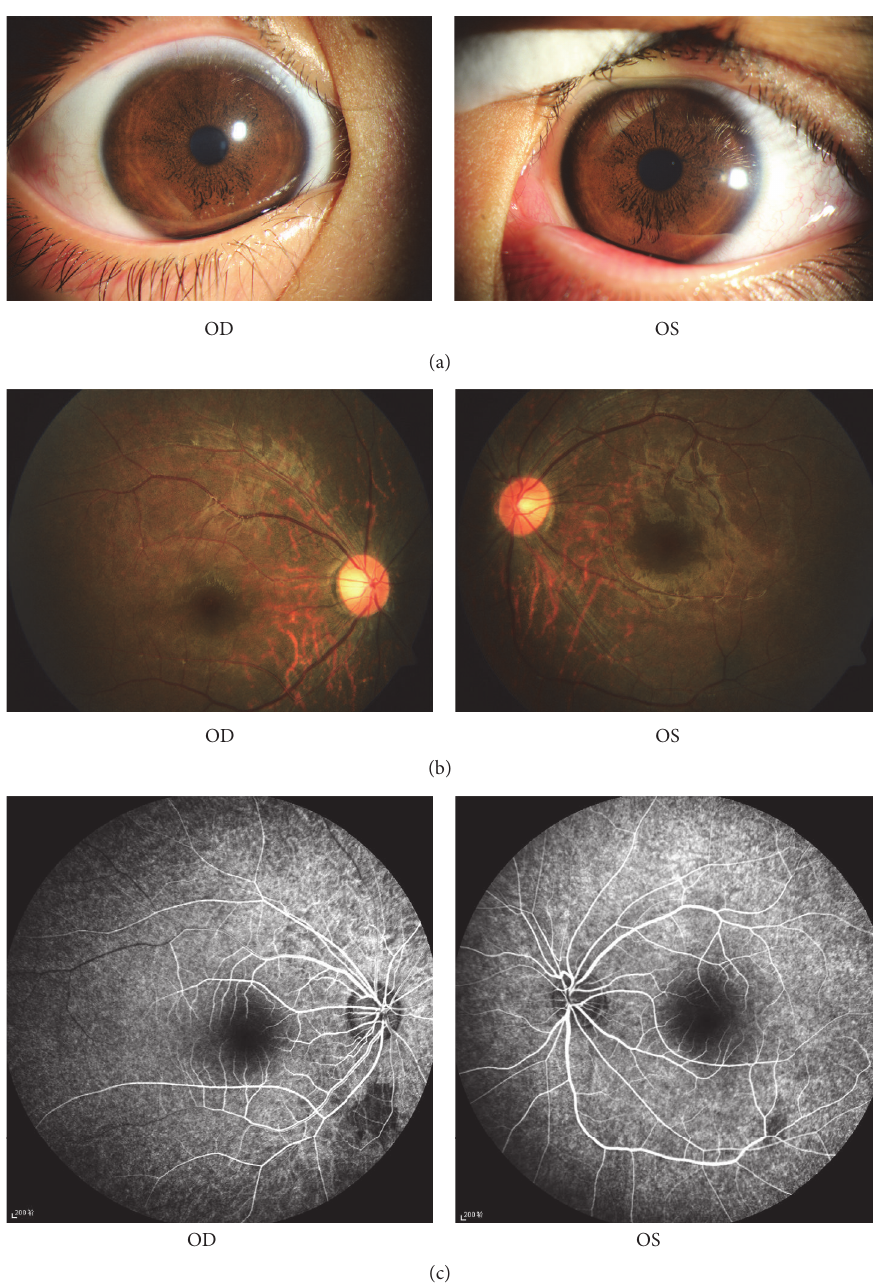
Figure 1: (a) shows the small black nodules on the surface of the iris in both eyes; (b) shows the pale optic disc, the mottling, and no bone spicule-like pigmentation fundus in both eyes; (c) shows the mottled lesions with hyper- and hypofluorescence in the posterior fundus and no leakage from the optic discs in both